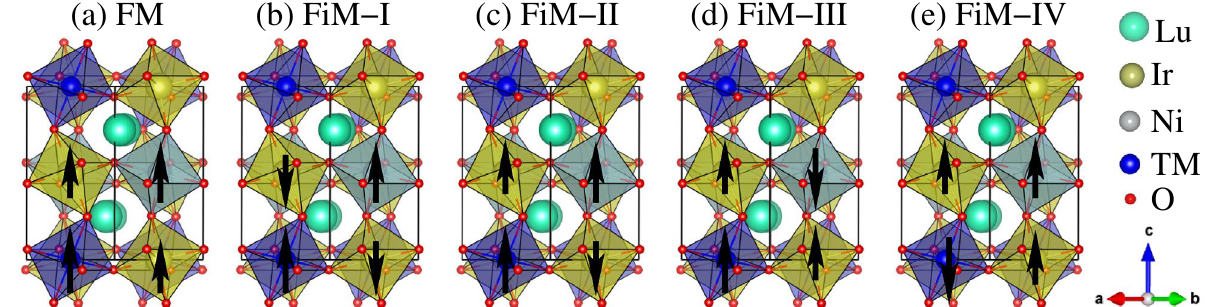
Figure 1. Schematic representation of the double perovskite structures of Lu 2 Ni 0.5 TM 0.5 IrO 6 (TM = Cr, Mn, and Fe) in ( a ) ferromagnetic (FM), ( b ) ferrimagnetic (FiM)-I, ( c ) FiM-II, ( d ) FiM-III, and ( e ) FiM-IV spin ordering. The tilted octahedral surroundings of the Ni, TM, and Ir with oxygen atoms are visualized in light grey, light blue, and light green colored polyhedron, respectively. The a , b , and c -axes are along the crystallographic x , y , and z -directions, respectively.